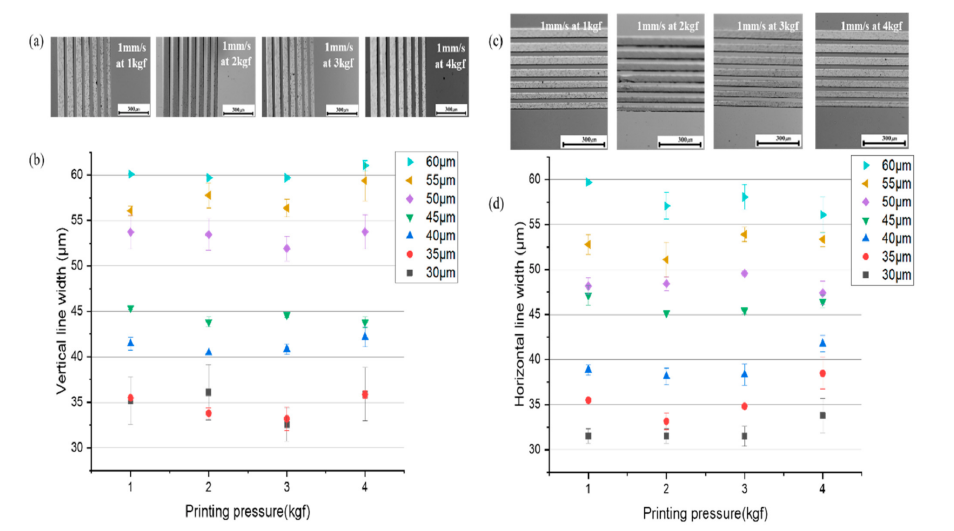
Figure 5. ( a , c ) Images of the vertical and horizontal printing patterns, respectively, based on the printing pressure on the 3D curved surfaces. ( b , d ) Comparison of the clich é line width and the line width according to printing pressure changes from 1 kgf to 4 kgf on the 3D curved surface (left: vertical, right: horizontal).